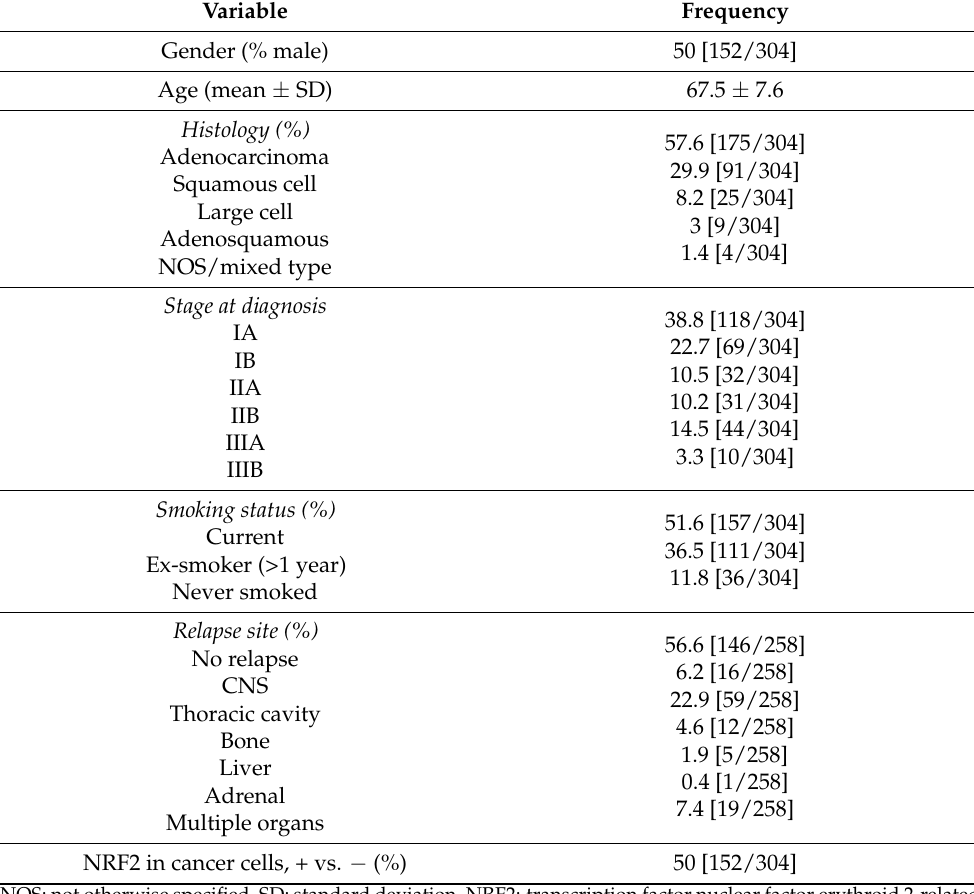
Table 1. Baseline demographics and disease characteristics. In square brackets, the absolute number of patients in each subgroup and the total number of patients with available information are shown.